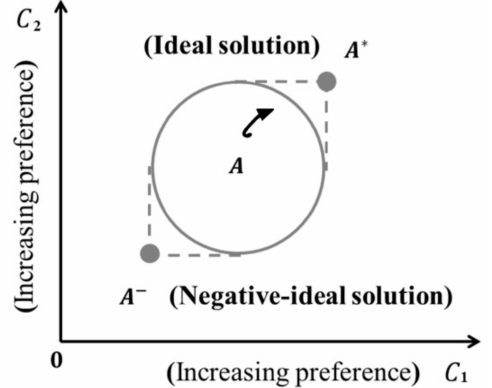
Figure 3. The compromise solution of the TOPSIS method.